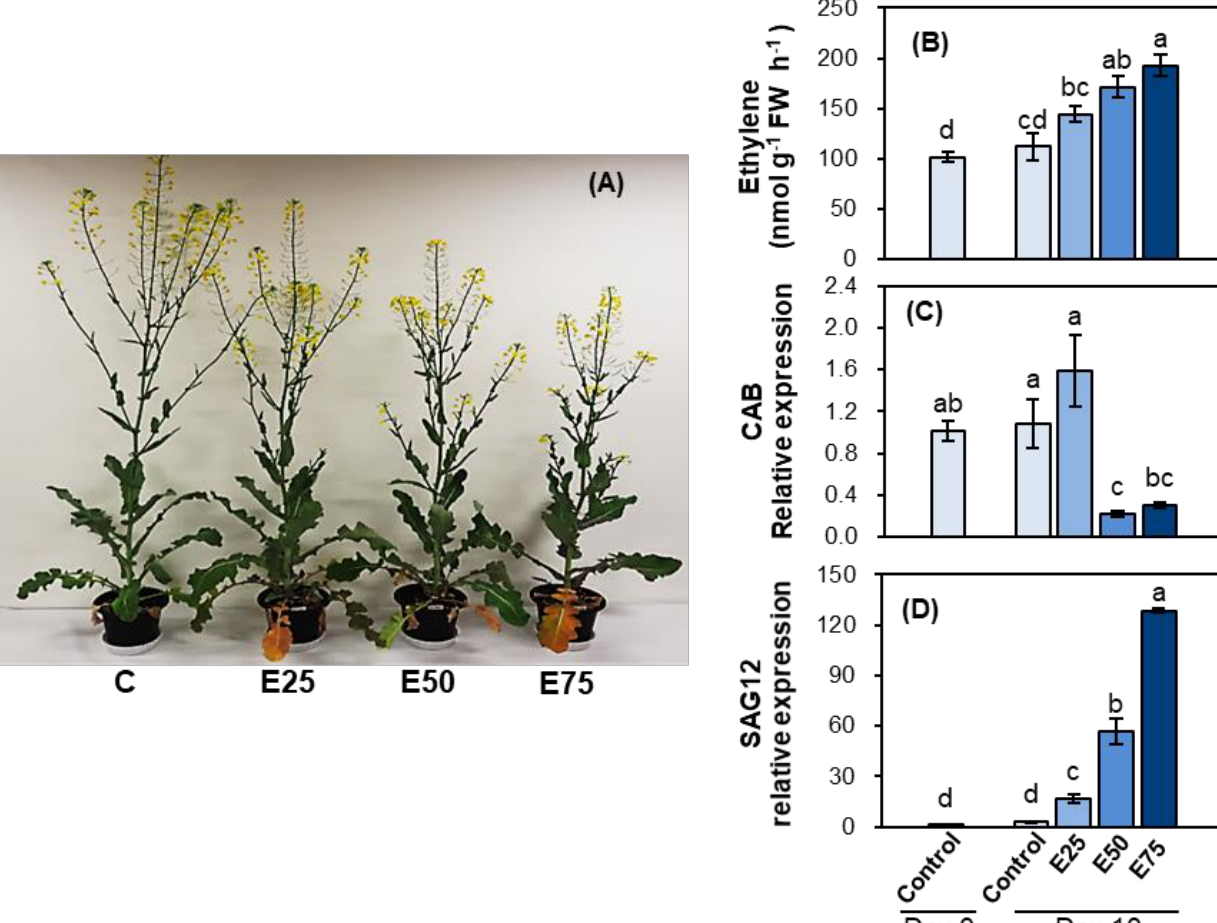
Figure 1. Short – term effects of different concentrations (0, 25, 50, or 75 ppm) of ethephon application on plant morphology, ethylene content and leaf senescence. ( A ) Plant morphology, ( B ) ethylene content, ( C ) chlorophyll a/b – binding protein ( CAB ), and ( D ) senescence-associated gene 12 ( SAG12 ) gene expressions in mature leaves of the control and ethephon-treated plants. Ethephon (0, 25, 50, or 75 ppm) was applied to foliar leaves of Brassica napus for 10 days. E25, E50, and E75 indicate foliar applied ethephon concentrations of 25, 50, and 75 ppm, respectively. Data are presented as mean ± SE ( n = 3). The qRT–PCR was performed in duplicate for each of the three independent biological samples. Different letters on columns indicate significant different ( p < 0.05) between treatments.